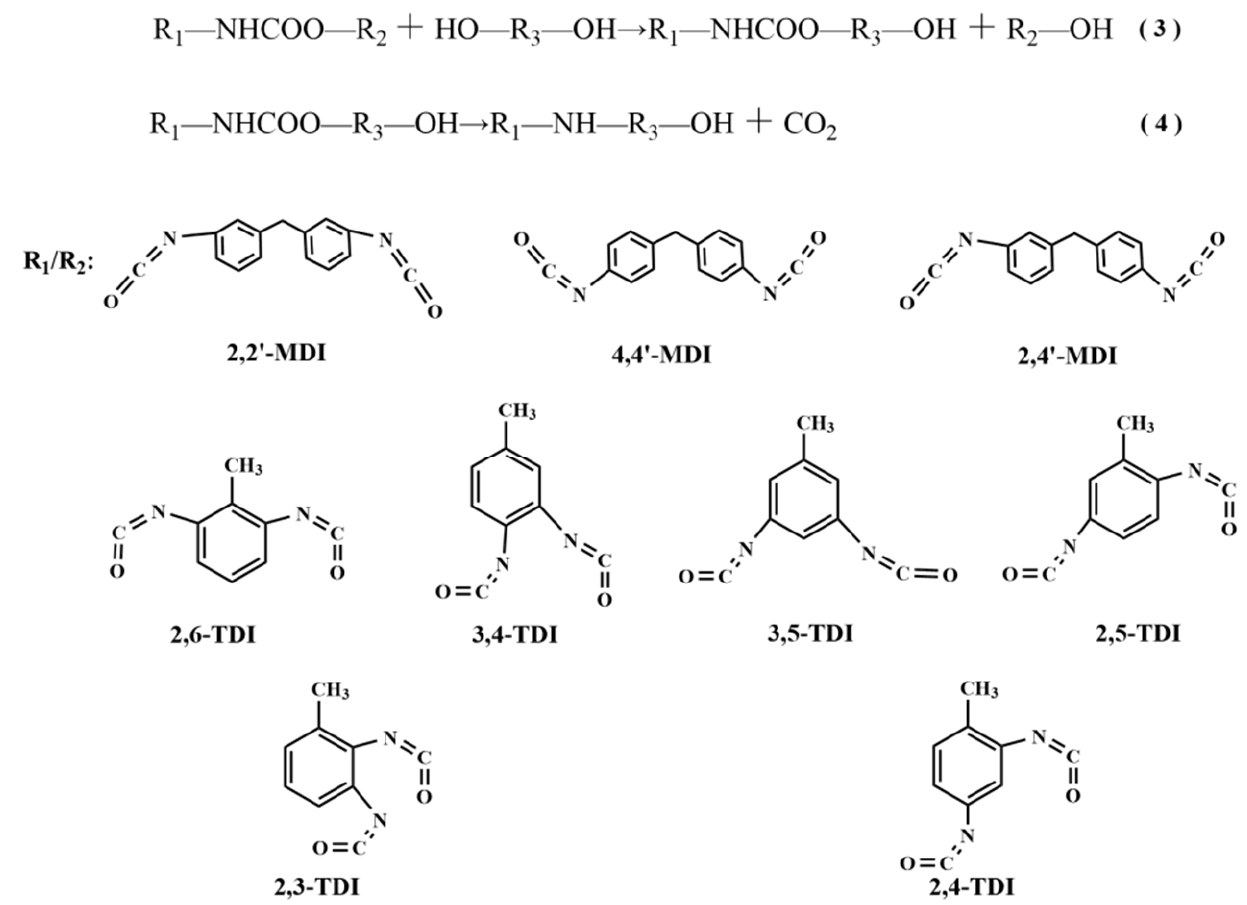
Figure 3. Figure 3. Mechanism of polyurethane foam degradation catalyzed by titanium ethylene glycol na- noparticles.